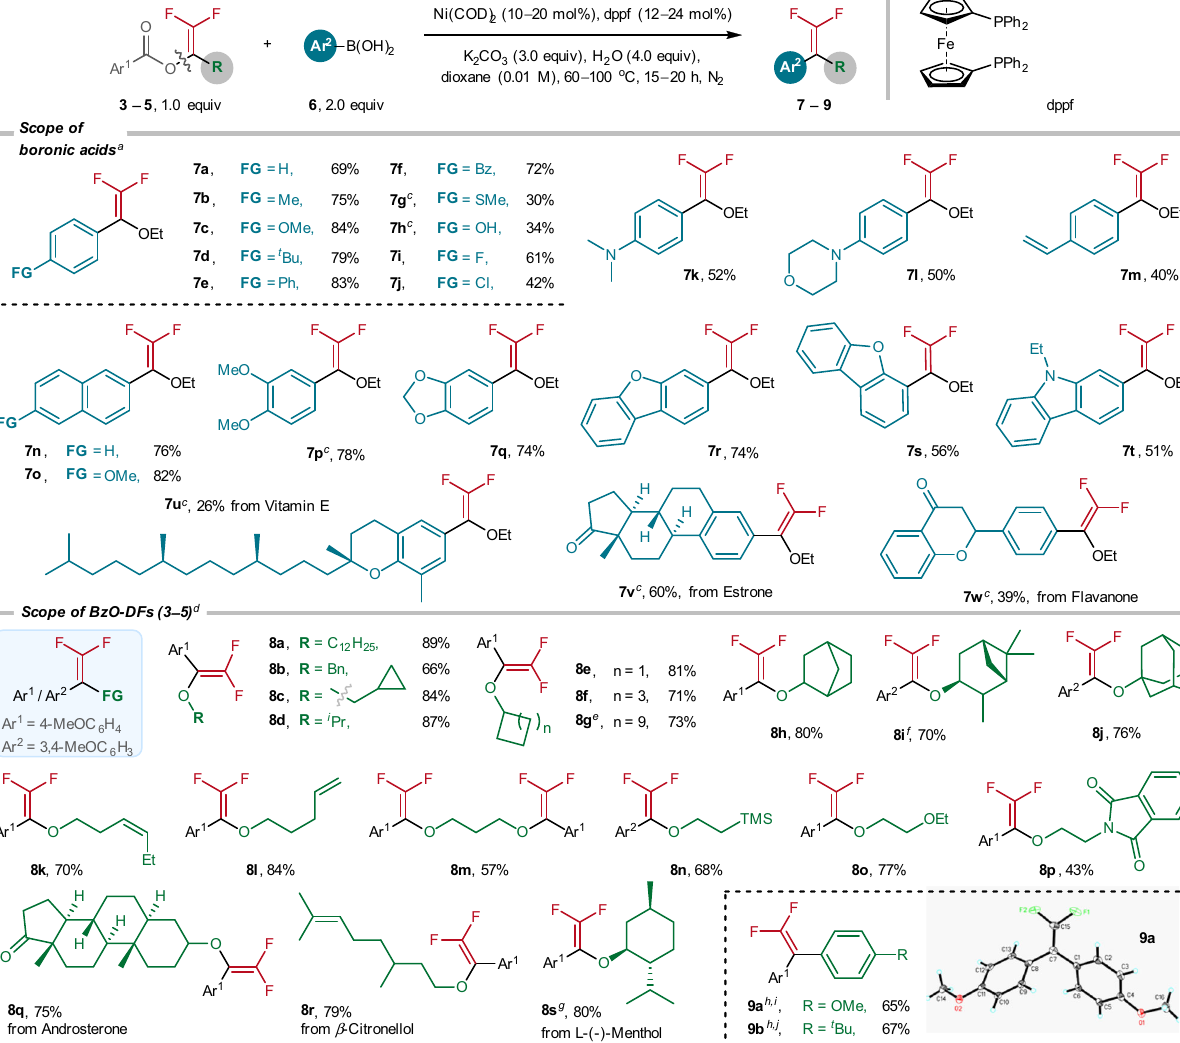
Fig. 3 Ni-catalyzed cross-coupling reactions of BzO-DFs 3 – 5 and arylboronic acids 6. a Reaction conditions: 3a (0.2 mmol), 6 (2.0 equiv), Ni(COD) 2 (10 mol%), dppf (12 mol%), H 2 O (4.0 equiv), K 2 CO 3 (3.0 equiv) in dioxane (0.01 M) at 80 o C, 20 h, N 2 . b Isolated yields. c Ni(COD) 2 (20 mol%), dppf (24 mol %), 80 o C, 20 h. d Reactions were performed at 60 o C for 15 h. e Using 4 g instead of 3a . f Using 4i instead of 3a . g Using 4r instead of 3a . h Ni(COD) 2 (20 mol %), dppf (24 mol%), 100 o C, 20 h. i Using 5c instead of 3a . j Using 5a instead of 3a